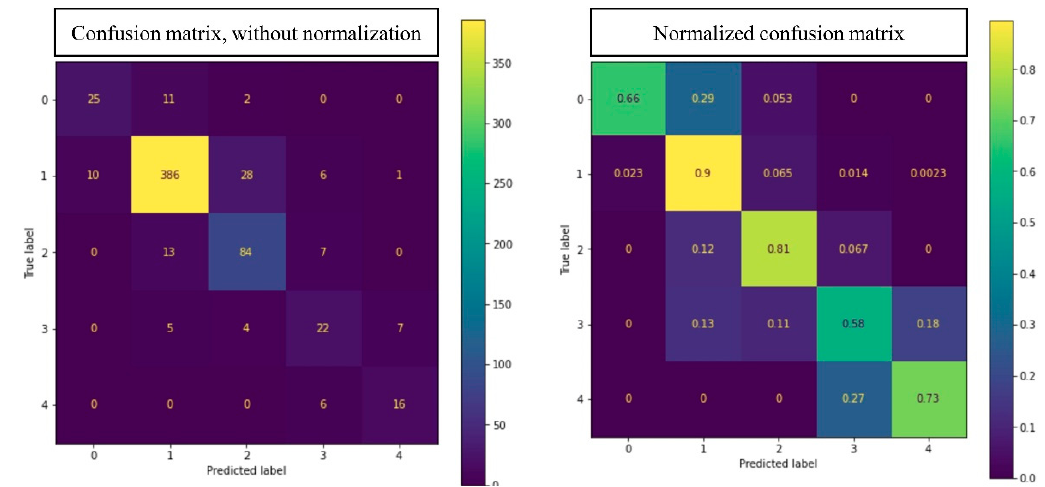
Figure 6. Confusion matrix with and without normalization on test set.